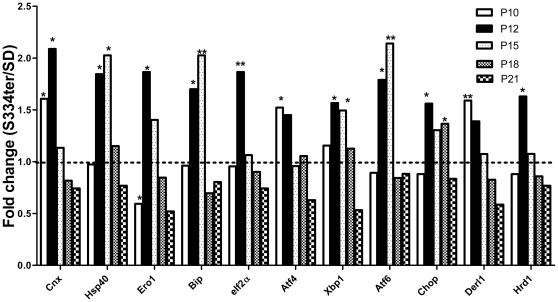
Relative expression of ER stress- and ERAD-related genes in S334ter-4 Rho retinas.The UPR gene expression was altered in S334ter-4 RHO retinas. Relative gene expression in S334tr Rho retina was measured on P10, P12, P15, P18 and P21 and a fold change was expressed as a ratio of S334ter-4Rho relative expression to SD relative expression. On P10, there was a significant reduction in the Ero1 gene expression suggesting that the ER homeostasis in S334ter-4 Rho retinas is imbalanced. The expression of this gene is decreased 2-fold (P<0.05, *) in S334ter-4 Rho retinas compared with SD retinas on P10. The increased expression of Calnexin (Cnx) and Atf4 genes are the first ER stress markers that respond to ER disturbance. The expression of these genes was increased 1.6- and 1.5-fold, respectively, (P<0.05, * in each case) on P10. On P12, the expression of other UPR upstream and downstream markers, such as Hsp40/Dnajc10, Ero1, Bip, eIf2a, Xbp1, Atf6 and Chop, were detected, which was indicated by relative increases of 1.8-, 1.8-, 1.5-, 1.9-, 1.6-, 1.8- and 1.6-fold, respectively, (P<0.05, * in each case with the exception of eIF2a where P<0.01, **). On P15, the Cnx, Ero1, eIf2a, Atf4 and Chop genes were expressed to a lesser extent or there was no significant difference in their expression levels in S334ter-4 Rho retinas compared with SD retinas. However, the Hsp40/Dnajc10, Bip, Xbp1 and ATf6 mRNAs were significantly induced on P15. Their relative expressions were 2-, 2-, 1.5- and 2-fold higher in S334ter-4 Rho retinas compared with the WT group (P<0.01 for Bip and Atf6, and P<0.05 for Hsp40/Dnajc10 and Xbp1). On P21, the expression of all genes was insignificant in the S334ter-4 Rho retinas compared with the SD retinas. Derl1 and Hrd1 gene expression was upregulated 1.5- and 1.6-fold on p10 and p12, respectively (P<0.05 in each case).